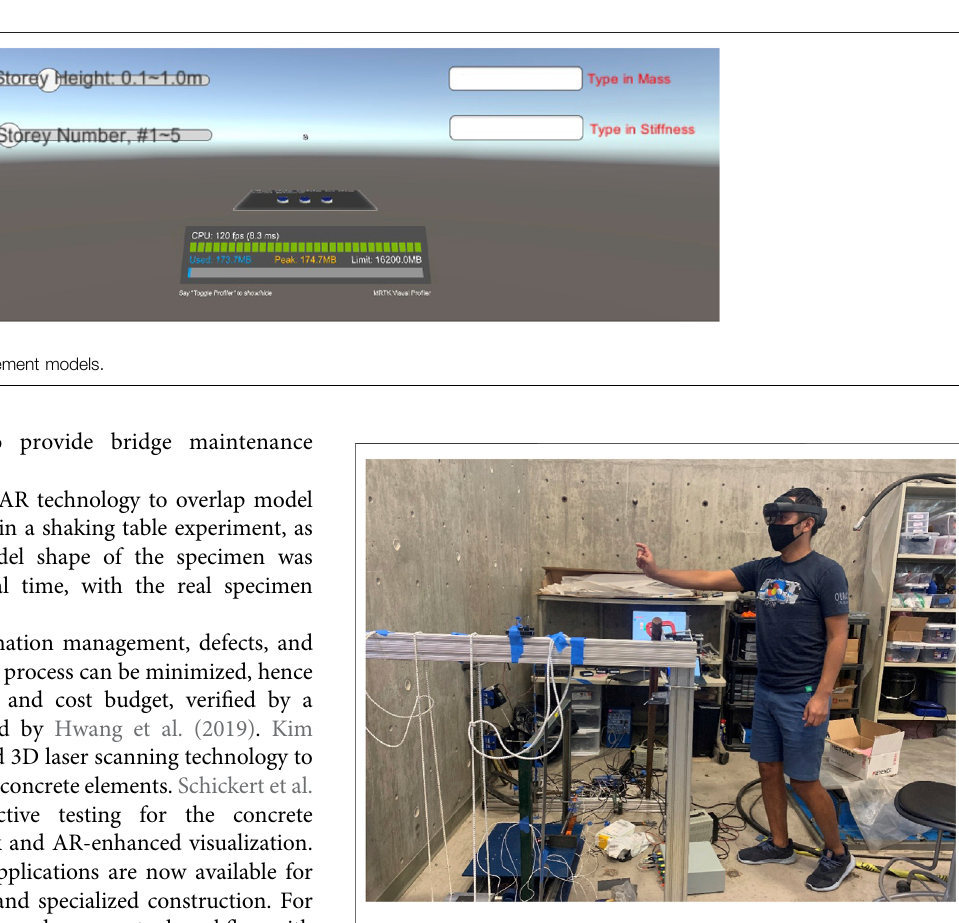
FIGURE 11 | Implementing AR in a shaking table